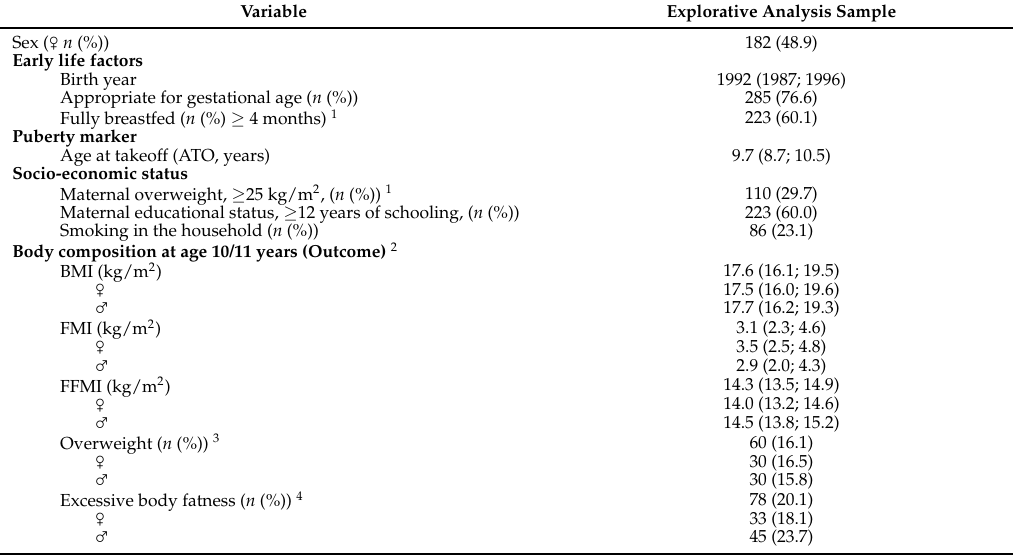
Table 1. Early life, pubertal, familial-, and socio-economic characteristics, as well as data on the outcome body composition (explorative analysis sample, N = 372).